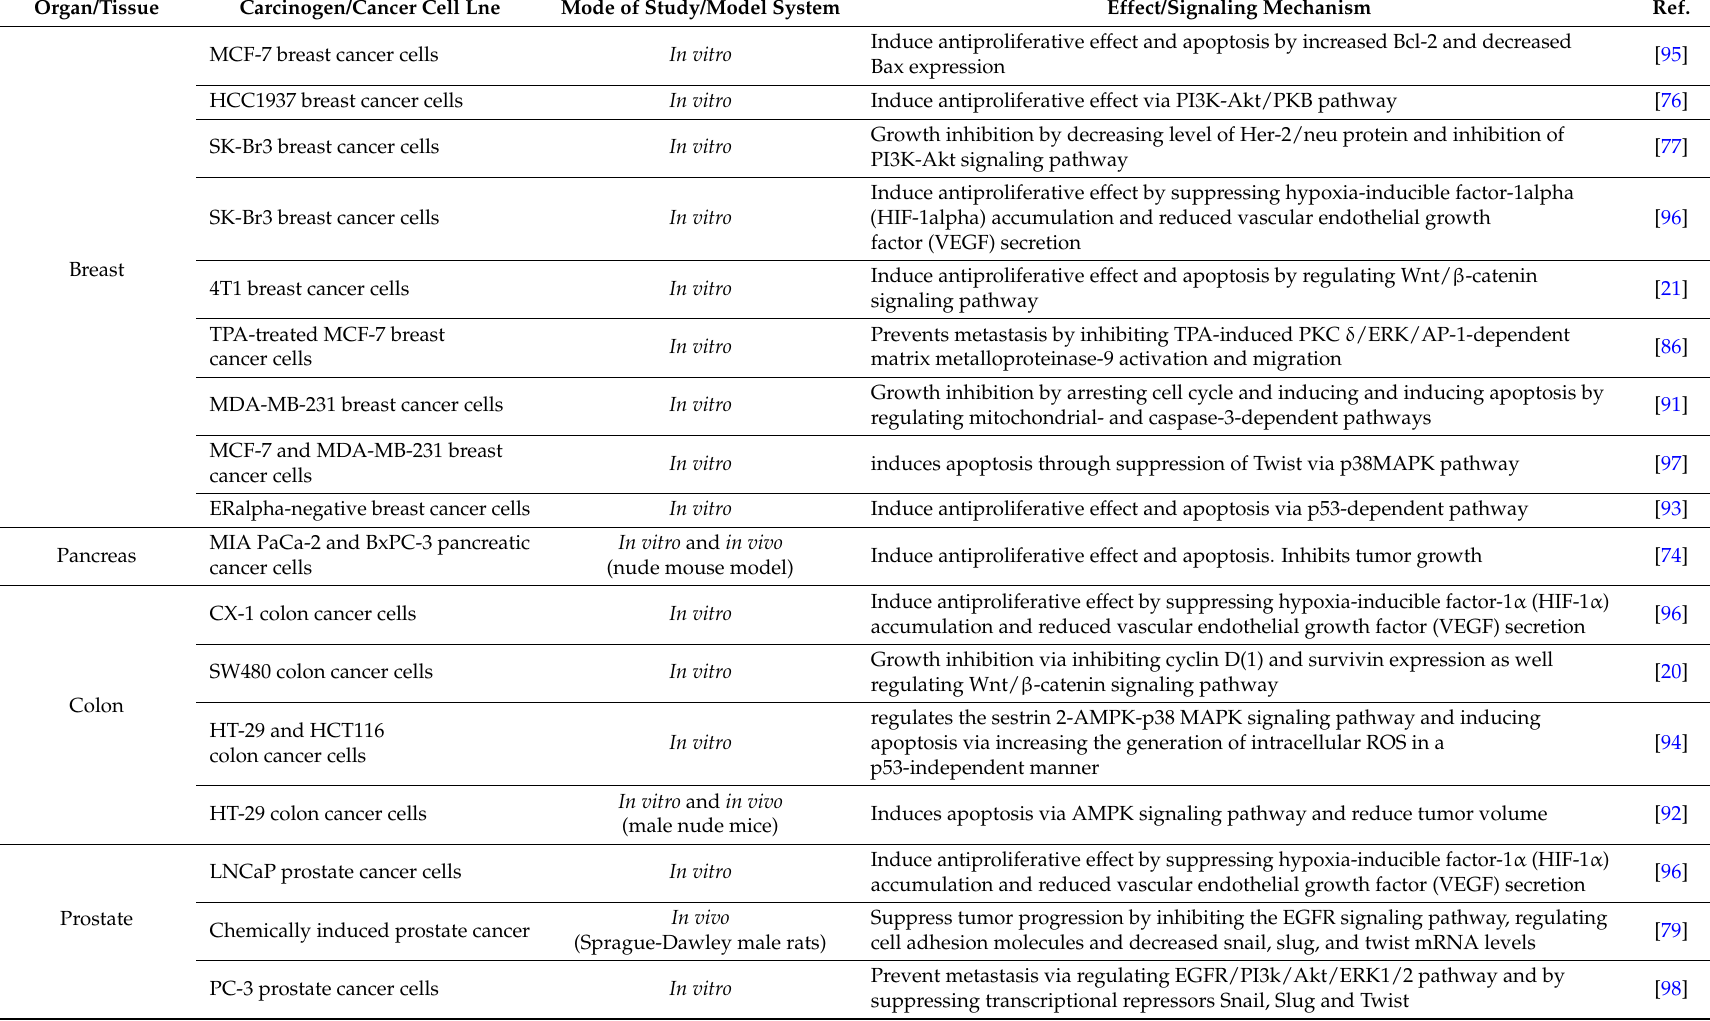
Table 1. Effects of quercetin on cancer types and cell signaling